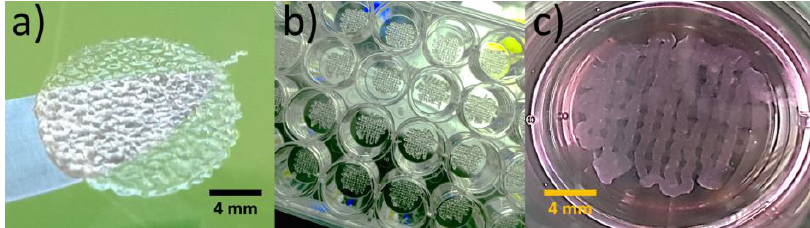
Figure 1. Representative images of 3D-bioprinted osteoblast constructs: ( a ) construct fully swelled, ( b ) 24 constructs automatically bioprinted in the cell culture plate and ( c ) construct immersed in cell culture medium at 37 ◦ C after crosslinking with CaCl 2 .